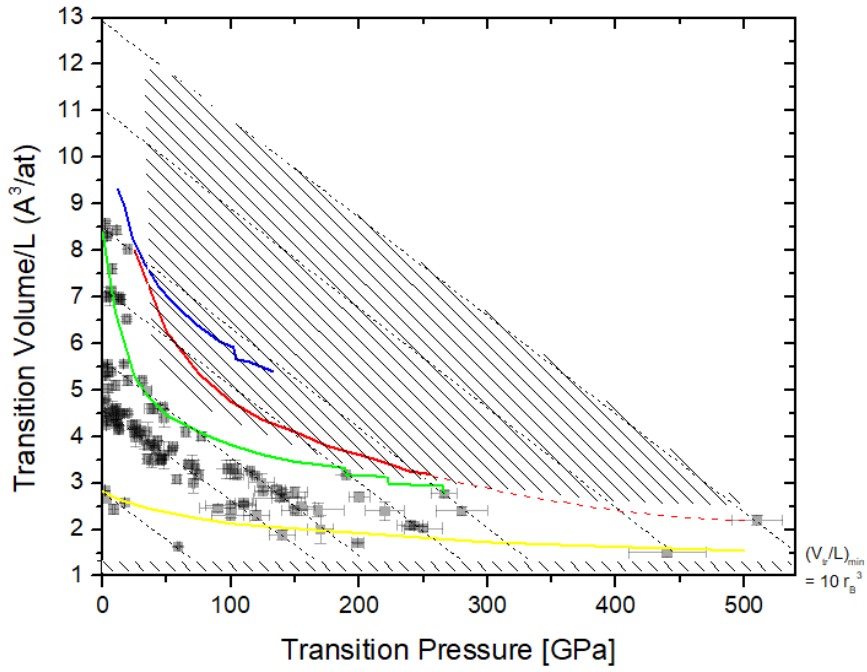
Figure 4. Data from Figure 1 with the equations of state for gold [24], chlorine [29], hydrogen [27], and oxygen [26] shown as yellow, green, red, and blue lines, respectively. Dashed lines indicate the distinct sets that defined V tr /L versus P as defined by Equation (1). The additional data points for hydrogen [32] and the second elastic anomaly of osmium [22] have been added. Hachured areas mark the molecular gap and the forbidden zone below V tr /L = 10 · r B3 .